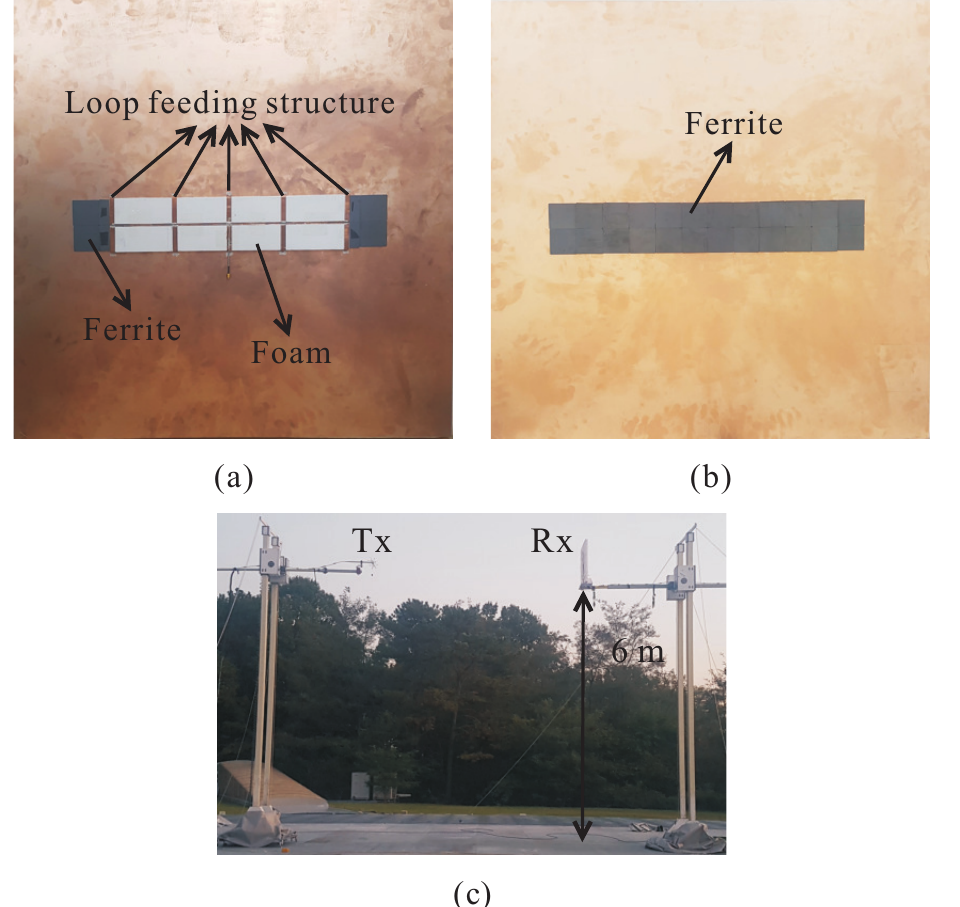
Figure 5. ( a ) Top view of the fabricated proposed antenna. ( b ) Top view of the fabricated ferrite. ( c ) Antenna measurement set-up.